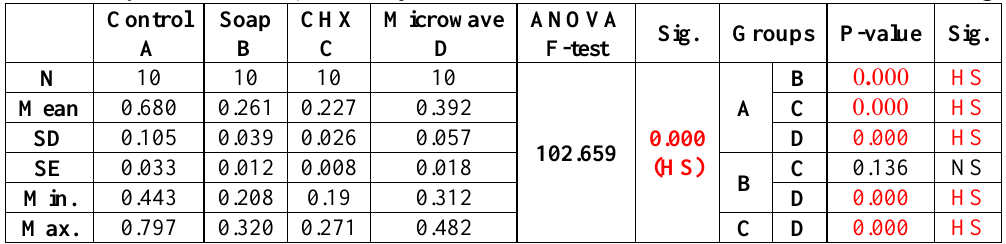
Table 3: Descriptive statistics, One-way ANOVA and Games-Howell test of Surface